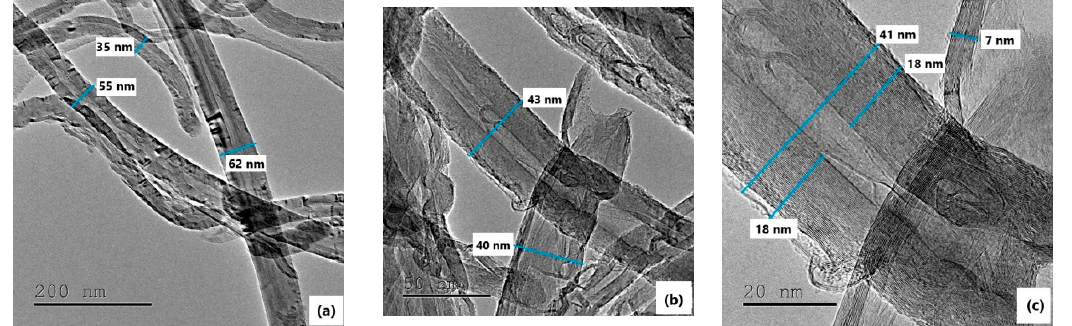
Figure 2. Low ( a ) and high magnification ( b and c ) TEM images of raw MWCNTs.